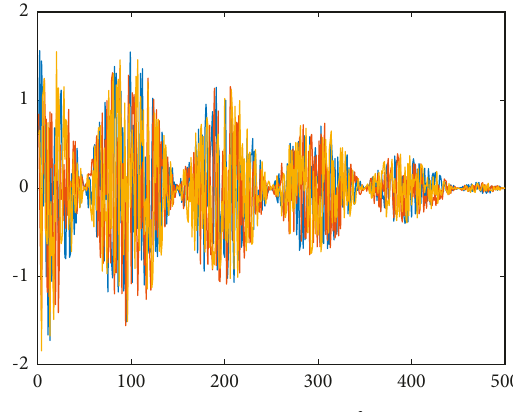
Figure 2: Energy escape